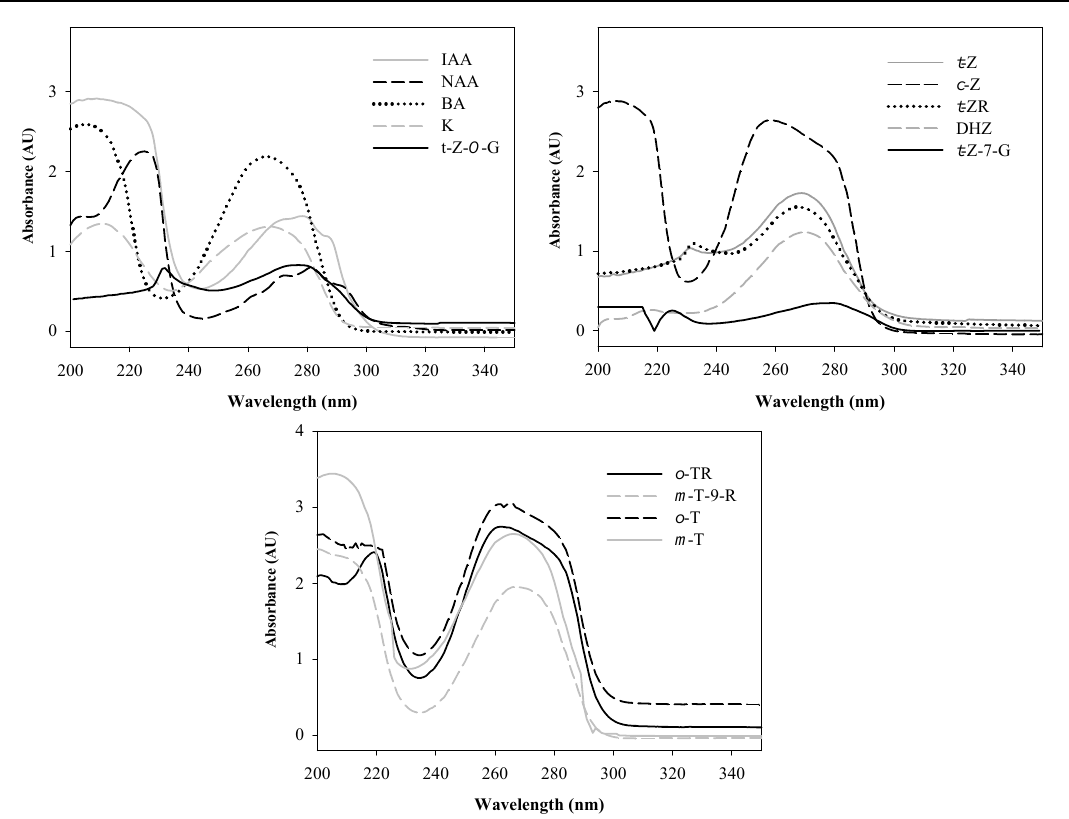
Figure 2. Molecular absorption UV spectra of the phytohormones. Phytohormone concentration: 20 μ g.mL -1 optical path length: 1